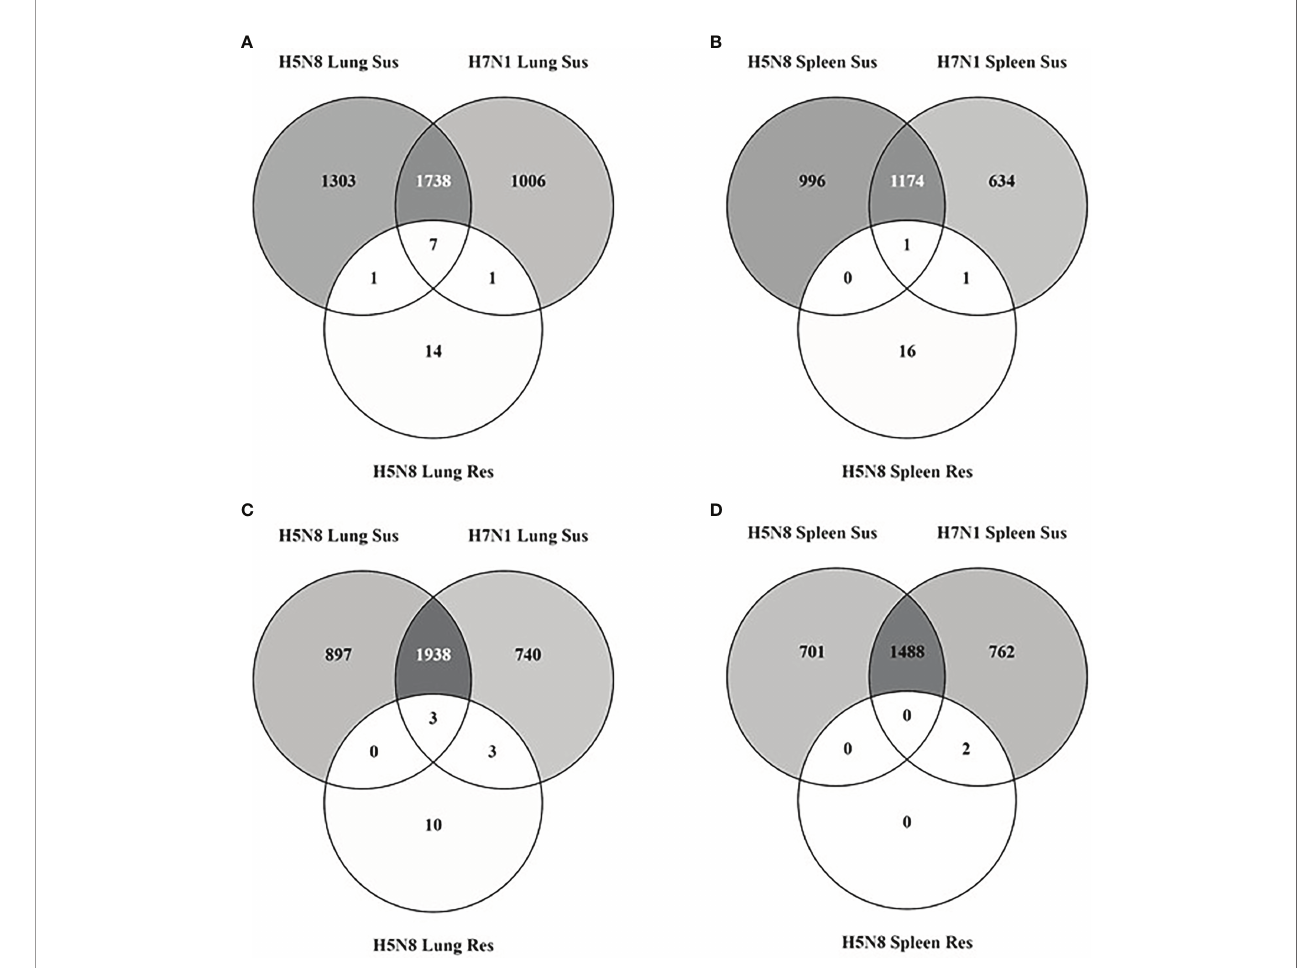
FIGURE 1 | Venn diagrams illustrating overlapping of DEGs identi fi ed in lungs [upregulated (A) and downregulated (C) ] and spleens [upregulated (B) and downregulated (D) ] collected at 3 dpi from susceptible (Sus) and resistant (Res) H5N8 and H7N1 inoculated